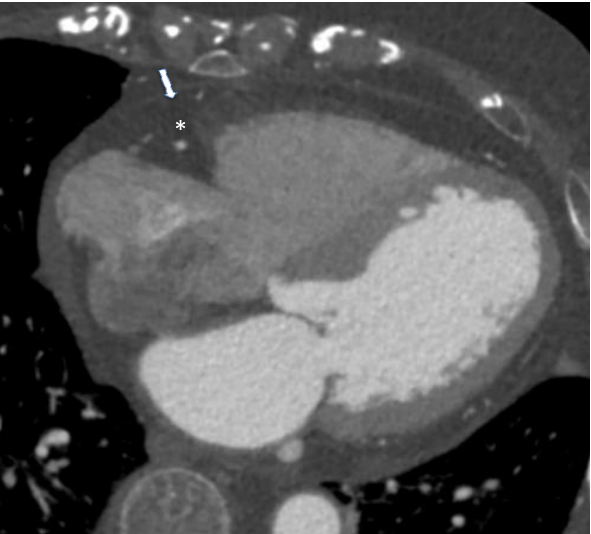
Figure 4. Case of an 85-year-old male patient underwent cardiac computed tomography angiography for the evaluation of coronary artery disease. Arrow identifies pericardium while asterisk represent epicardial adipose tissue. From Giuseppe Muscogiuri’s private archive of unpublished cardiac imaging.